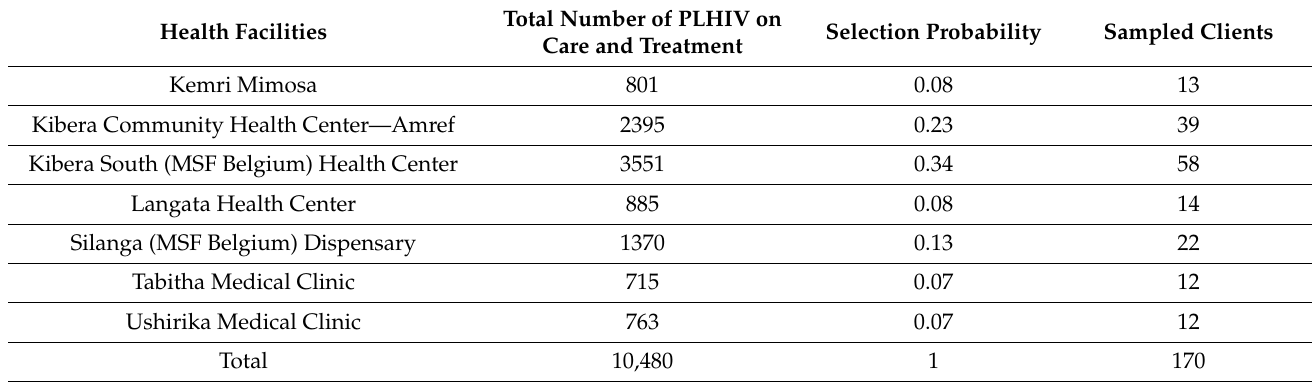
Table 1. Sample size distribution by